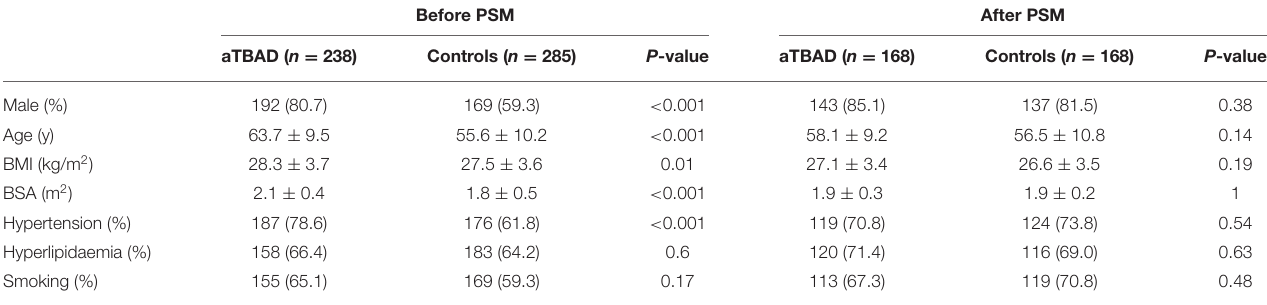
TABLE 1 | Population characteristics before and after propensity score matching in study